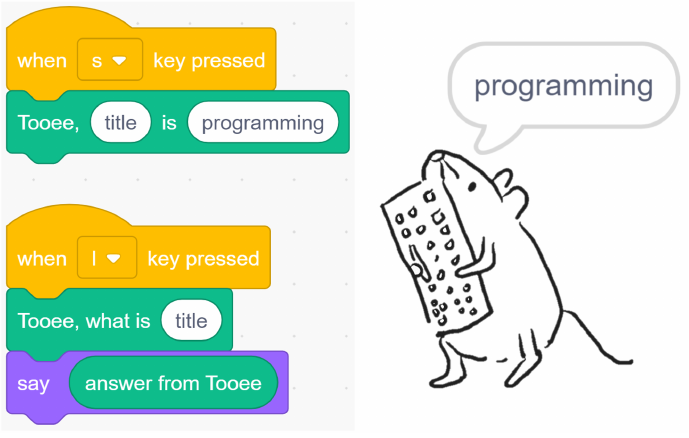
Figure 8. An example program for storing and retrieving data in the form of key–value